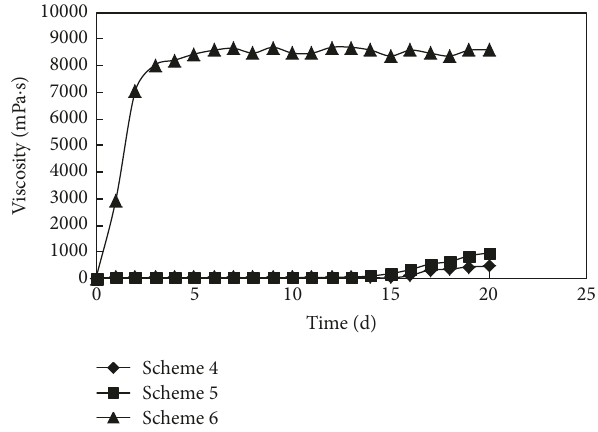
Figure 2: The changing process of viscosity when the concentration of polymer P was 2500